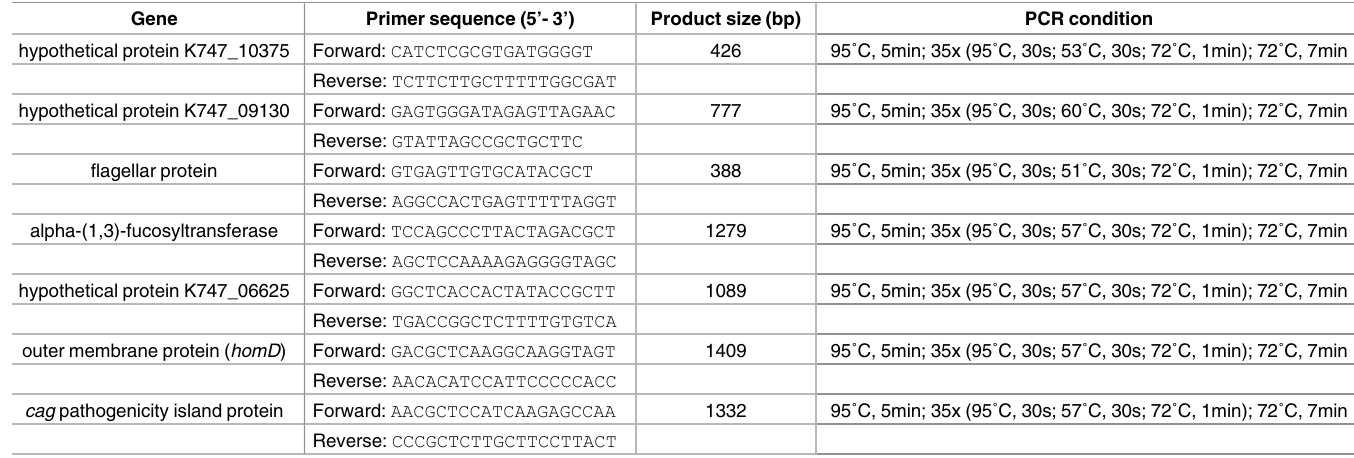
Table 2. Primers used for amplification of H . pylori biofilm